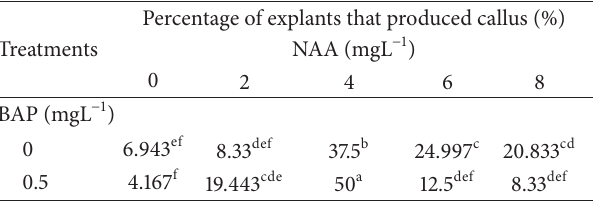
Table 3: Effects of the combination NAA and BAP at different concentrations on the percentage of callus induction from petiole explants.